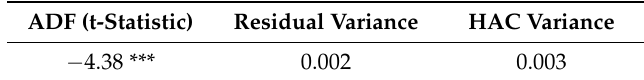
Table 10. Kao (Engle Granger based) test